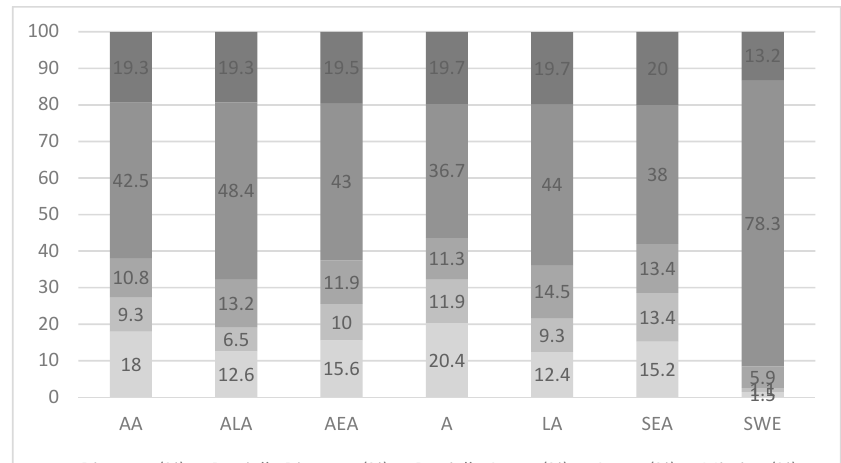
Figure 1. Can you imagine marrying someone of the following origin? Respondents with a white European background (N = 416, %) .